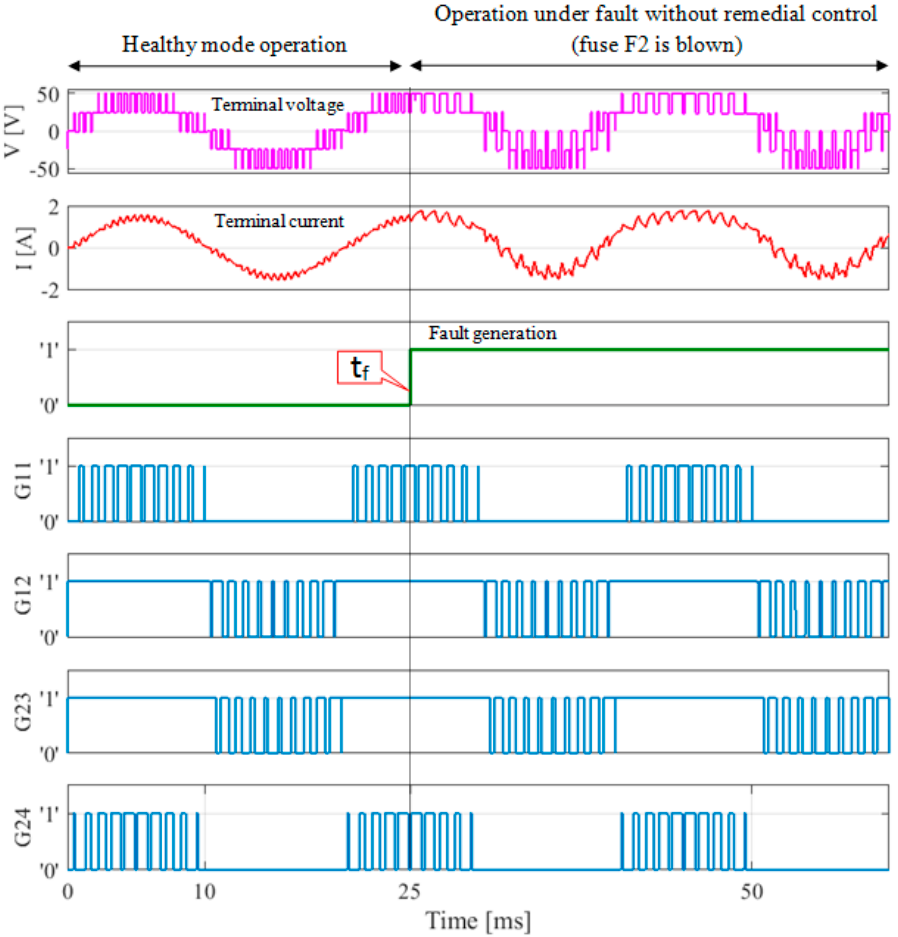
Figure 3. Simulation results for operation of the inverter under a short-circuit fault event in S11 without applying remedial control.